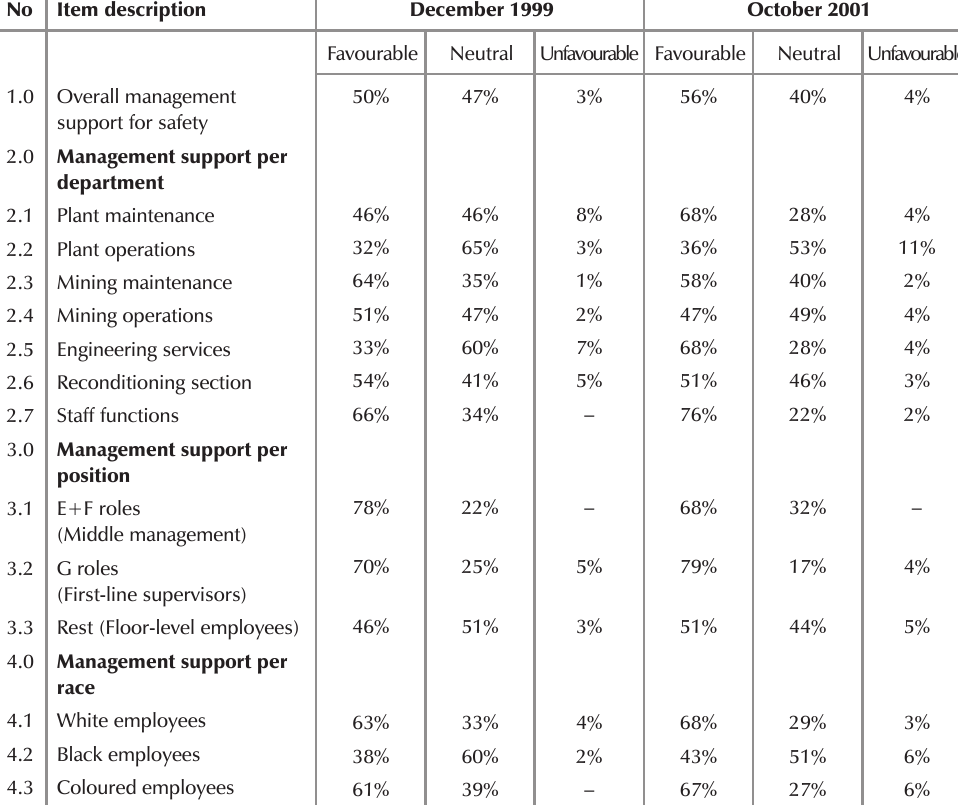
Outcome of culture survey with regard to management support for